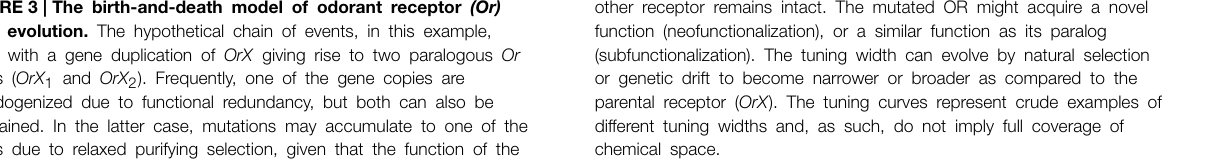
FIGURE 3 | The birth-and-death model of odorant receptor (Or) gene evolution. The hypothetical chain of events, in this example, starts with a gene duplication of OrX giving rise to two paralogous Or genes ( OrX 1 and OrX 2 ). Frequently, one of the gene copies are pseudogenized due to functional redundancy, but both can also be maintained. In the latter case, mutations may accumulate to one of the genes due to relaxed purifying selection, given that the function of the